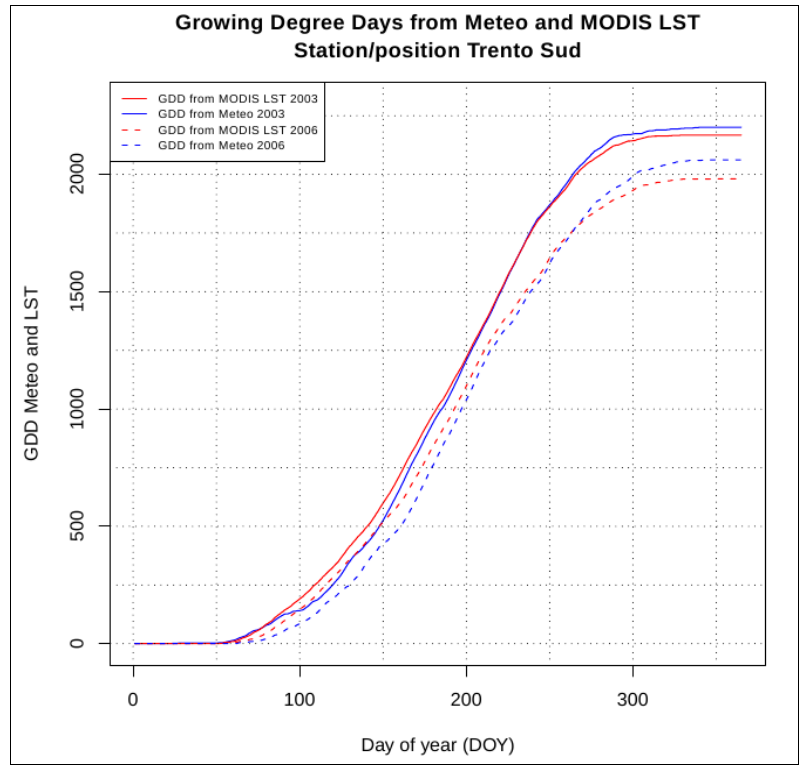
Figure 7. Comparison of accumulated growing degree day curve from FEM-CTT meteorological station and MODIS LST for 2003 and 2006: time series of the meteorological station (blue dashed) versus MODIS LST values (red) as extracted from 1,460 reconstructed Aqua/Terra scenes at the pixel position of the Trento-Sud station in the Autonomous Province of Trento (11.126386E, 46.021841N; baseline temperature 10 °C, cut-off temperature 30